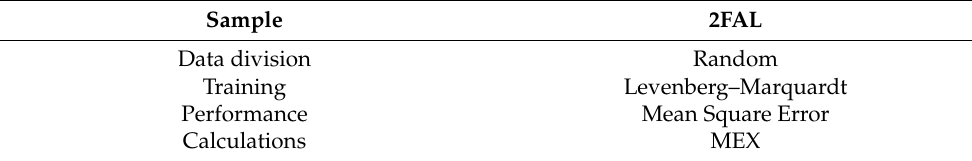
Figure 6. Performance plot of the proposed ANN model. Table 1. ANN algorithm